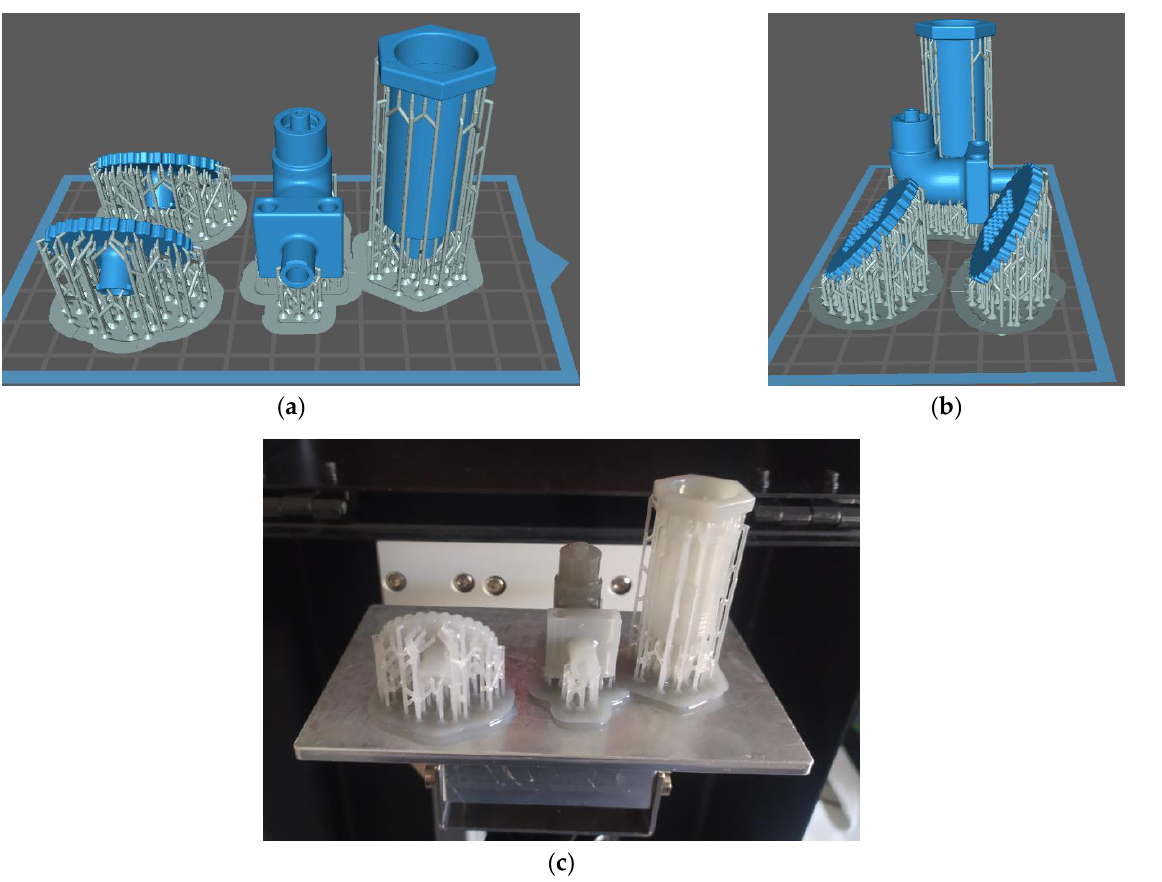
Figure 13. ( a , b ) Front and side views of the placement of the parts on the platform with the supports; ( c ) 3D printed components with the platform facing upwards.